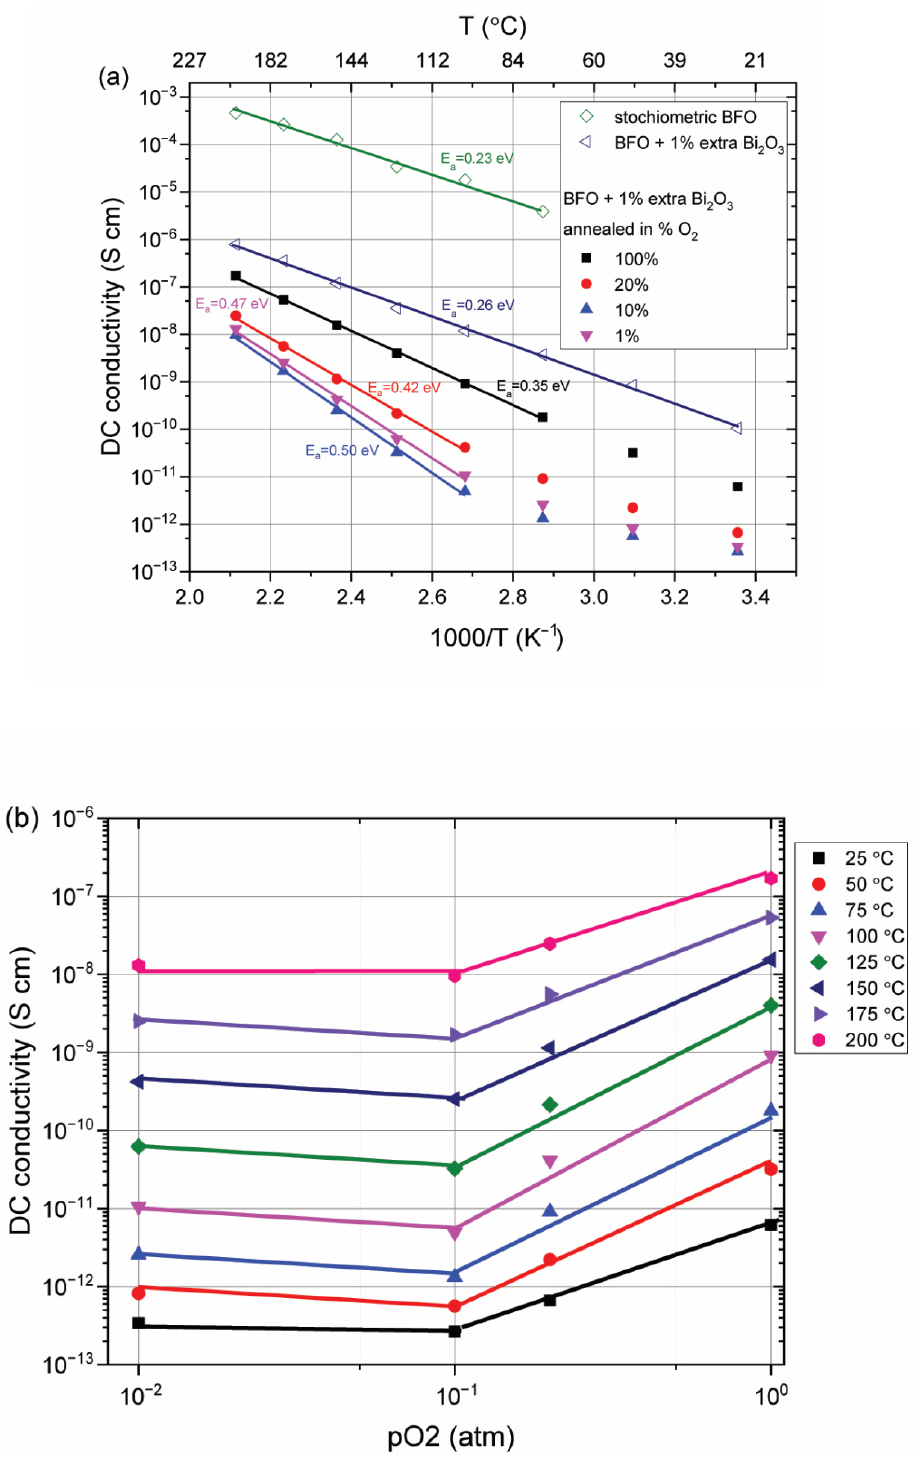
Figure 6. Conductivity of BFO samples prepared and annealed in different atmospheres. ( a ) Arrhenius plot of DC conductivity as a function of inverse temperature for reheated samples after annealing and linear cooling from 750 ◦ C. ( b ) DC conductivity measured in air over the temperature range from 25 to 200 ◦ C for samples synthesized from non-stoichiometric precursors for various oxygen partial pressures during high-temperature processing.